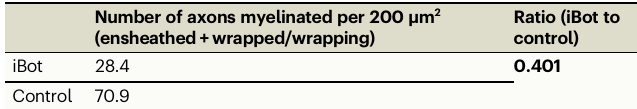
Table 2 | Calculation for relative myelination by cross- sectional TEM (iBot to WT) Number of axons myelinated per 200 μ m 2